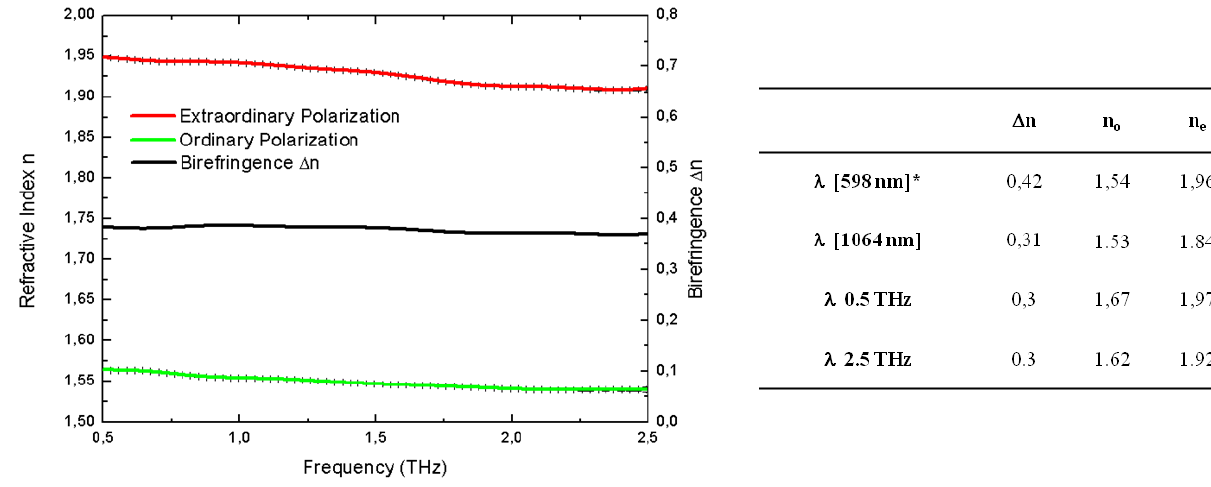
* ∆n was measured by the infrared method in wedge-shaped cells [52] and it is a little lower than given above in the main text. Optical indices in THz range were measured by M. Reuter from Koch’s laboratory (Marburg University,